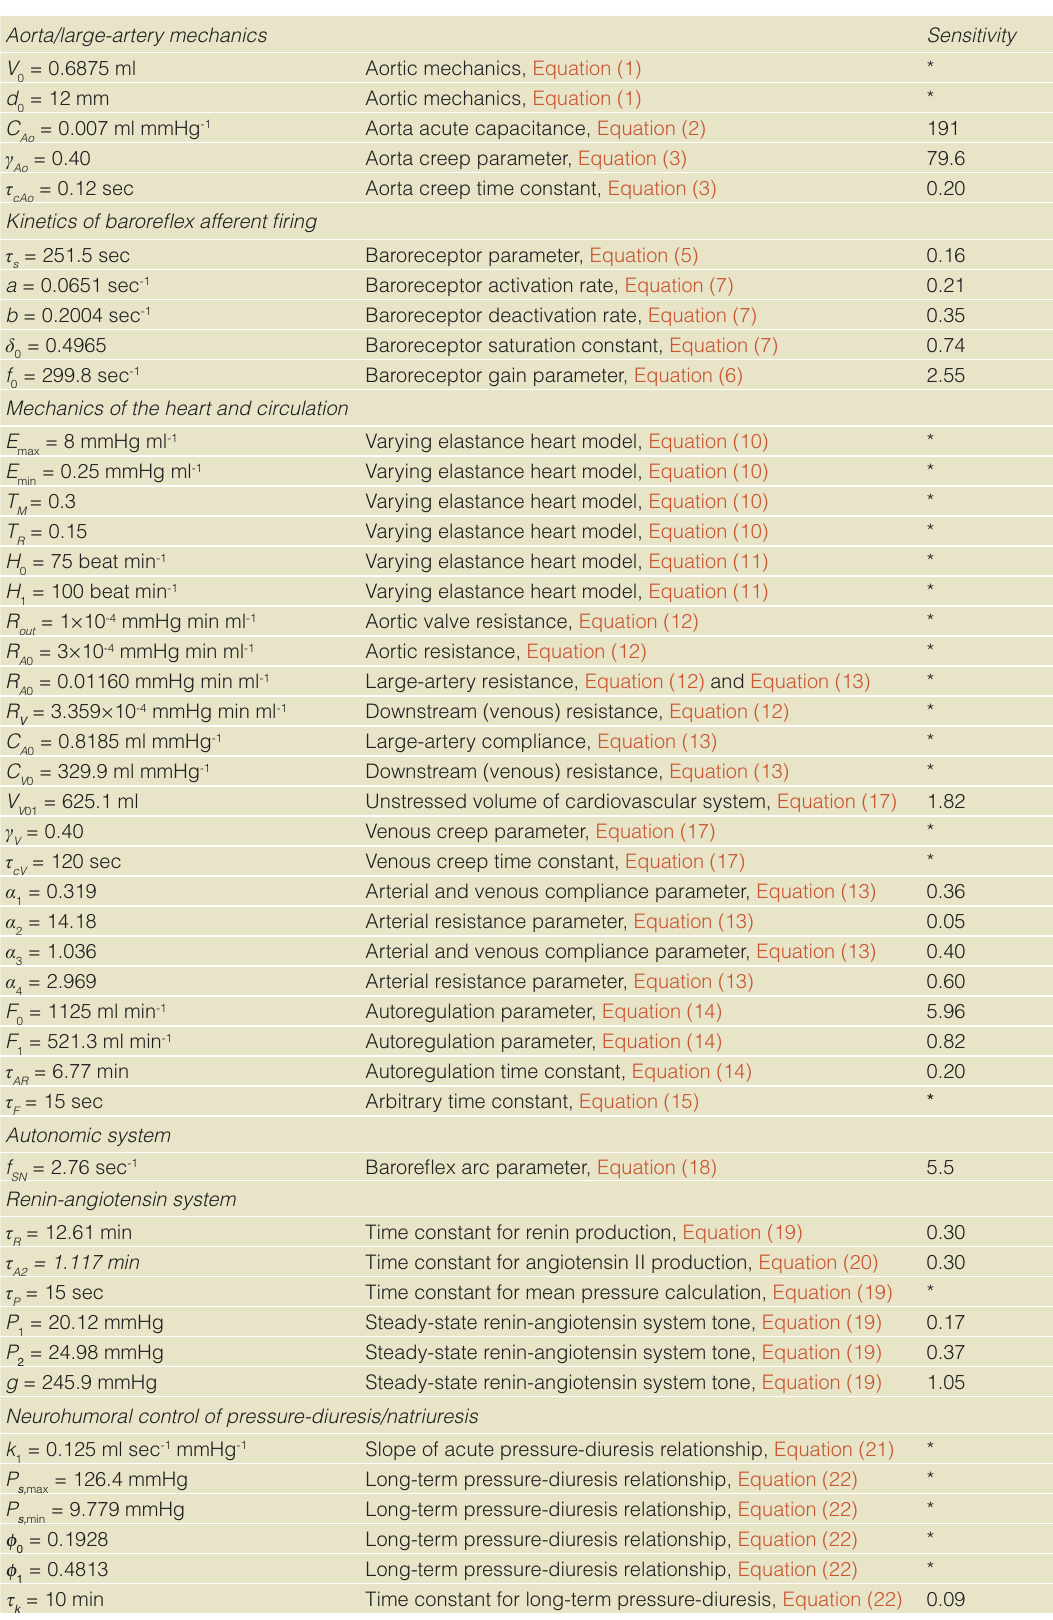
Table 1. Model parameters. Aorta/large-artery